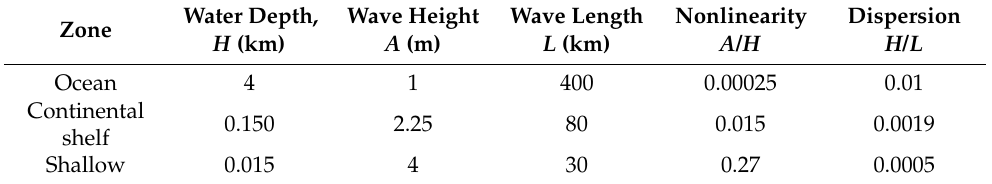
Table 1. Estimated parameters of tsunami waves for the most realistic underwater earthquakes.